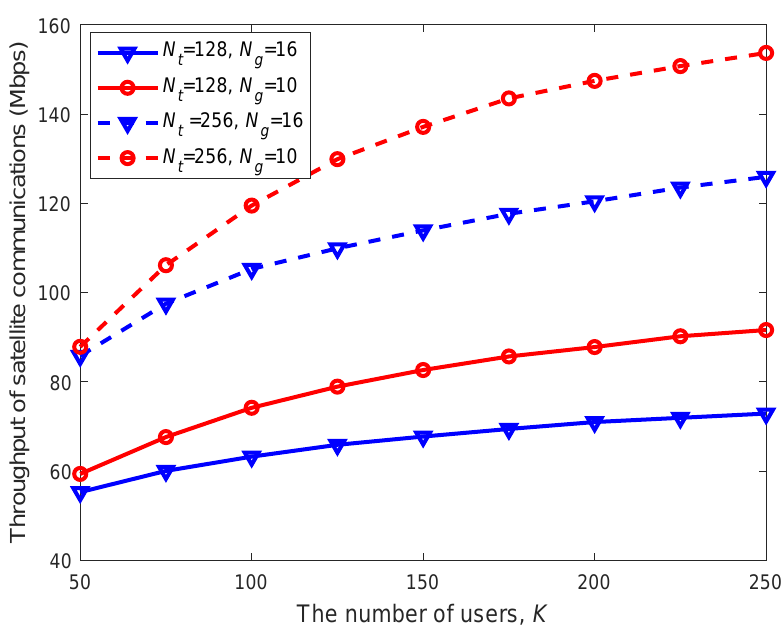
Figure 5. Satellite throughput with different numbers of antennas and gateways (under FFR pattern without CR, β =